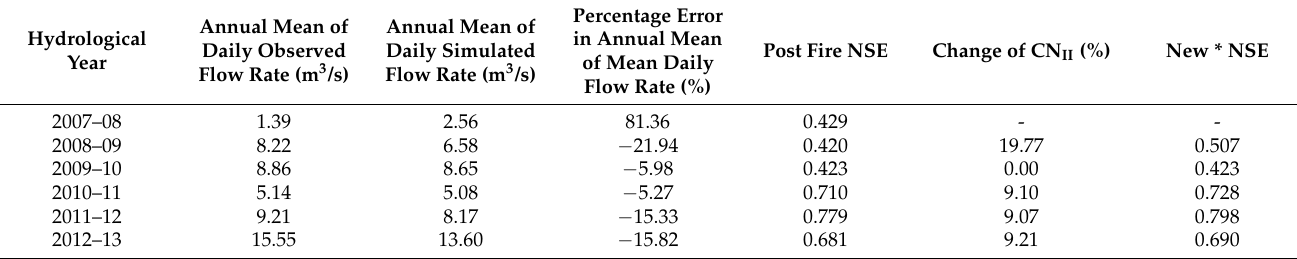
Table 3. Results of post-fire modelling using